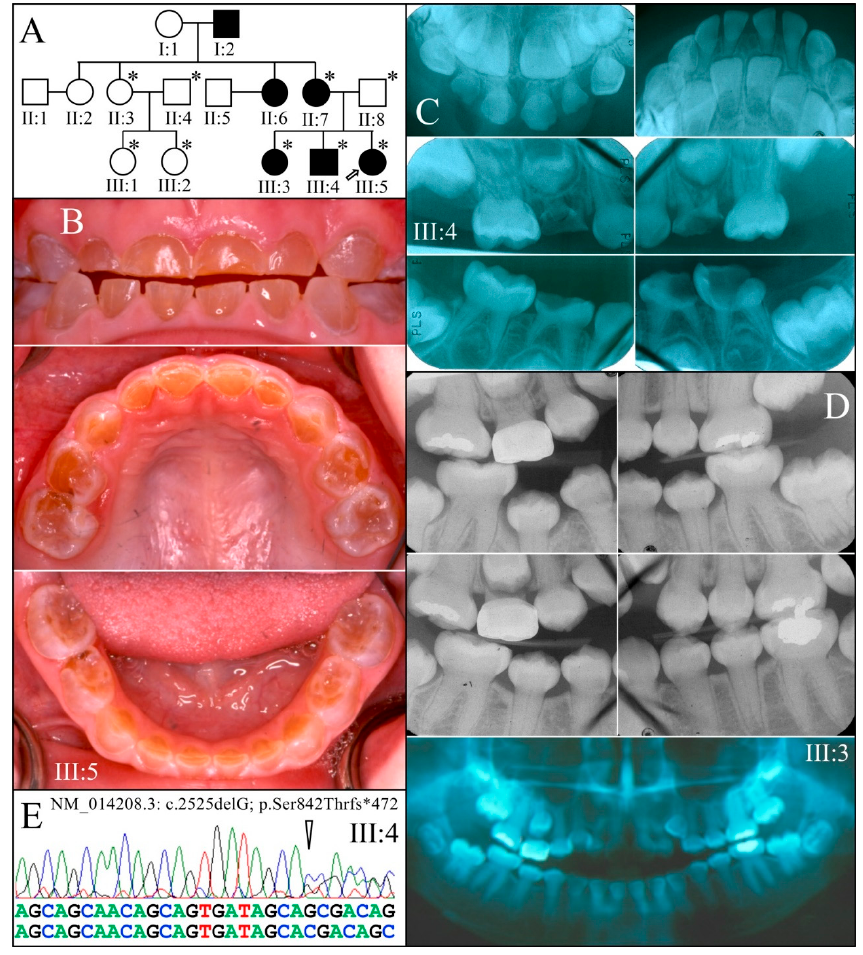
Figure 11. Family 8 from the USA. ( A ): Three-generation pedigree of a family diagnosed with DGI-II following an autosomal dominant pattern of inheritance. Recruited members are indicated by an asterisk. ( B ): The dental phenotype of the proband (III:5) at age 3-years showed amber- brown discoloration and accelerated attrition of the primary dentition. ( C ): Radiographs of affected younger brother (III:4) at age 3-years. ( D ): Radiographs of the affected older sister (III:3) taken at age 11 (top) and age 12 (bottom). Panorex radiograph of III:3 at age 12 showing a permanent dentition with bulbous crowns with obliterated pulp chambers, and short roots on the anterior teeth. ( E ): DNA sequence chromatogram showing the heterozygous DSPP − 1 frameshift (c.2525delG p.Ser842Thrfs*472) that segregated with the DGI-II phenotype. Key : * denotes enrolled